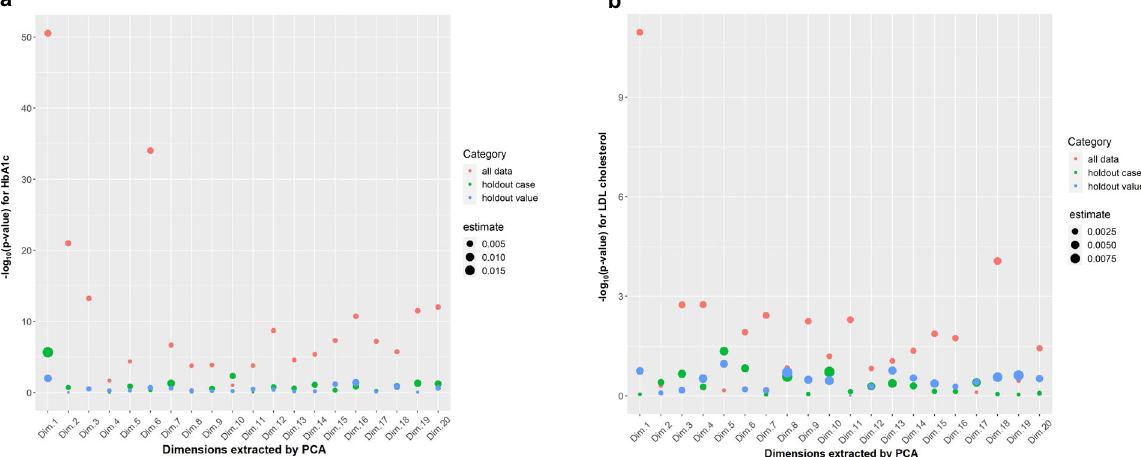
Fig. 3 This missingness (dummy variables) was highly associated with comorbidity. HbA1C ( a ) in GNSIS dataset and LDL cholesterol ( b ) in HF dataset was one of the most valuable laboratory variables used in the prediction model for the outcome of interest in ischemic stroke and/ or heart failure. PCA was conducted by R “ factoextra “ package. Dim represented the dimensions extracted from the comorbidity matrix using prcomp function; The y -axis represented log-transformed p -value of the signi fi cance of the difference (absolute value) in principal component values between observed and missing groups after Welch unpaired t -test.